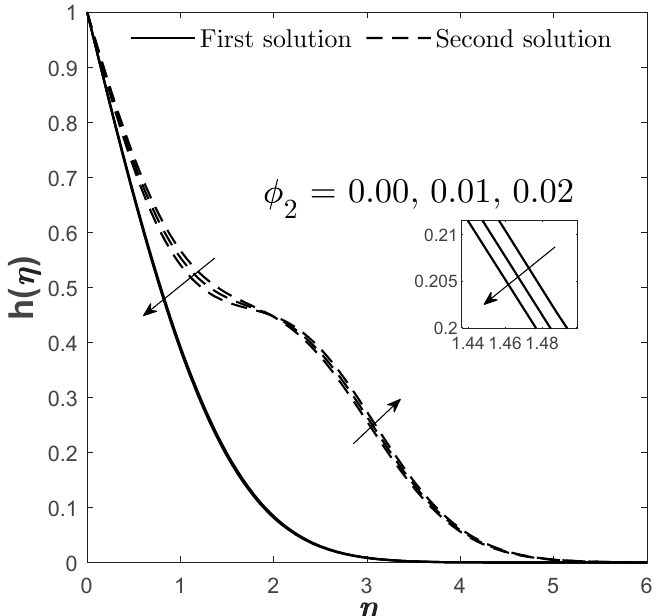
Figure 13. Plots of h ( η ) for varied φ 2 when N = Rd = Sc = Sr = 1, λ = − 1, Du = 0.03, and Bi = Figure 13. Plots of